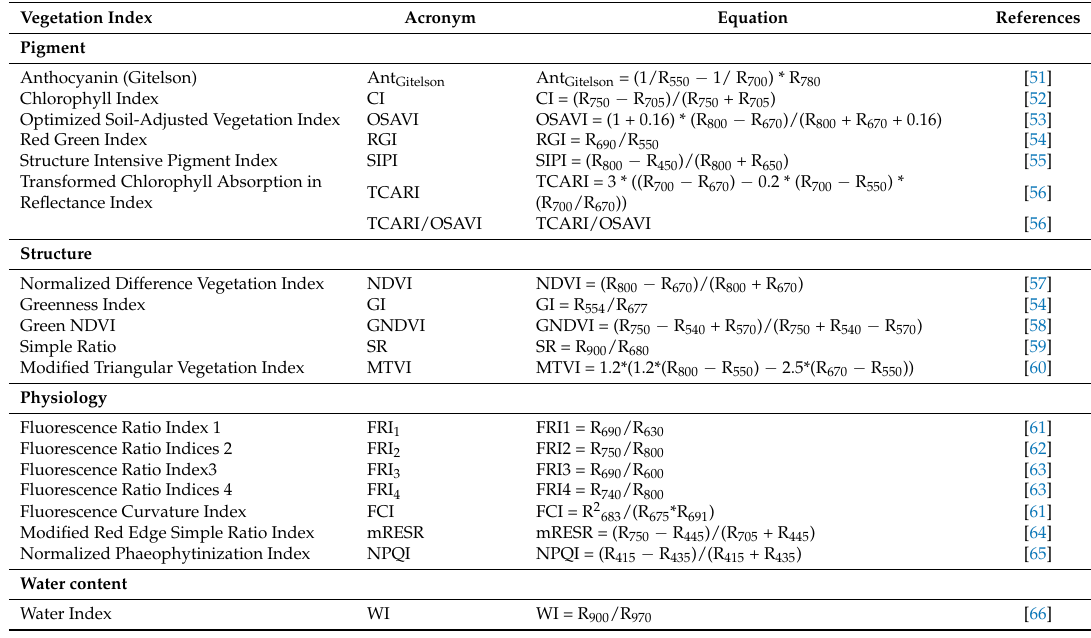
Table 1. Vegetation indices used in this study.